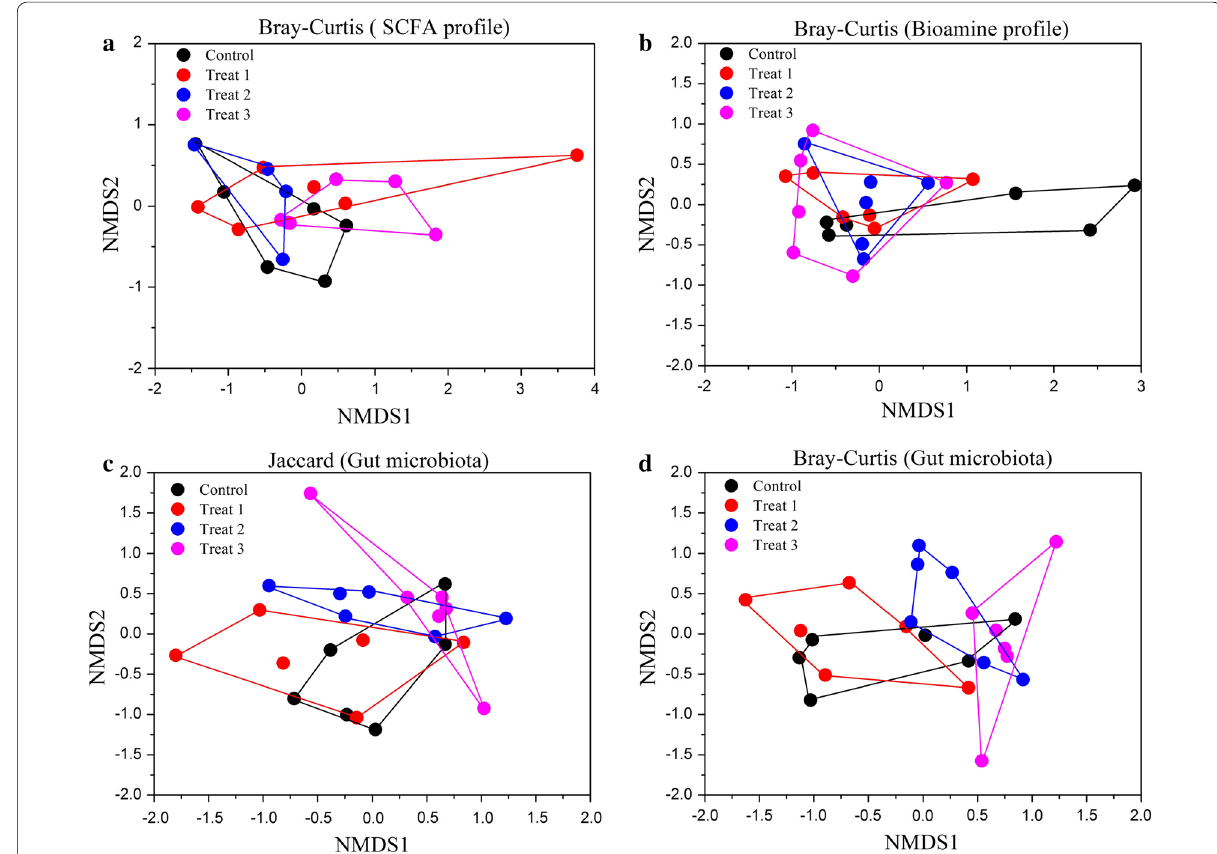
Fig. 1 NMDS plots of dissimilarity metrics comparing the profiles of gut microbiota, SCFAs and bioamines among groups. a SCFA profile based